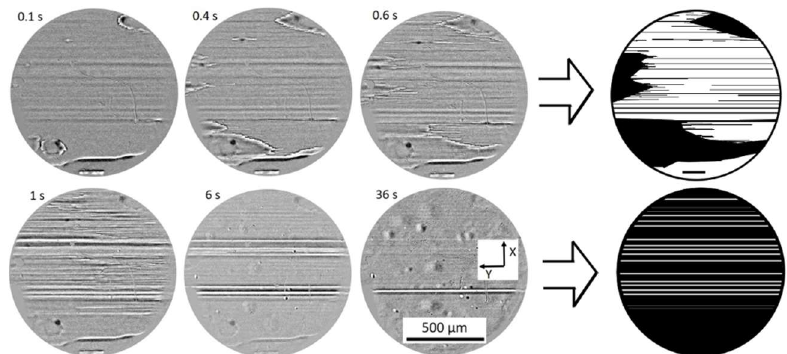
Figure 5. The instantaneous images of domain structure during polarization reversal with artificial dielectric layer. Optical microscopy, transmitted light. External field 5.2 kV/mm. The black-and-white images on the right side are the sketches of domain structure at 0.6 s and 36 s, correspondingly. The switched domains are indicated by black color.